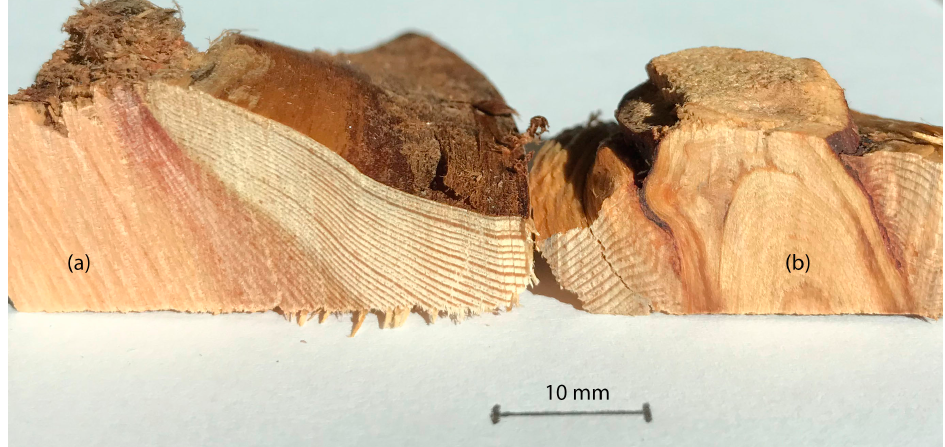
Figure 1. ( a ) One example of a larch wood chip with a sound knot and the intact connection between knot and stem wood; ( b ) a larch wood chip with a dead knot and the inclusion of bark as well as oxidized resin.